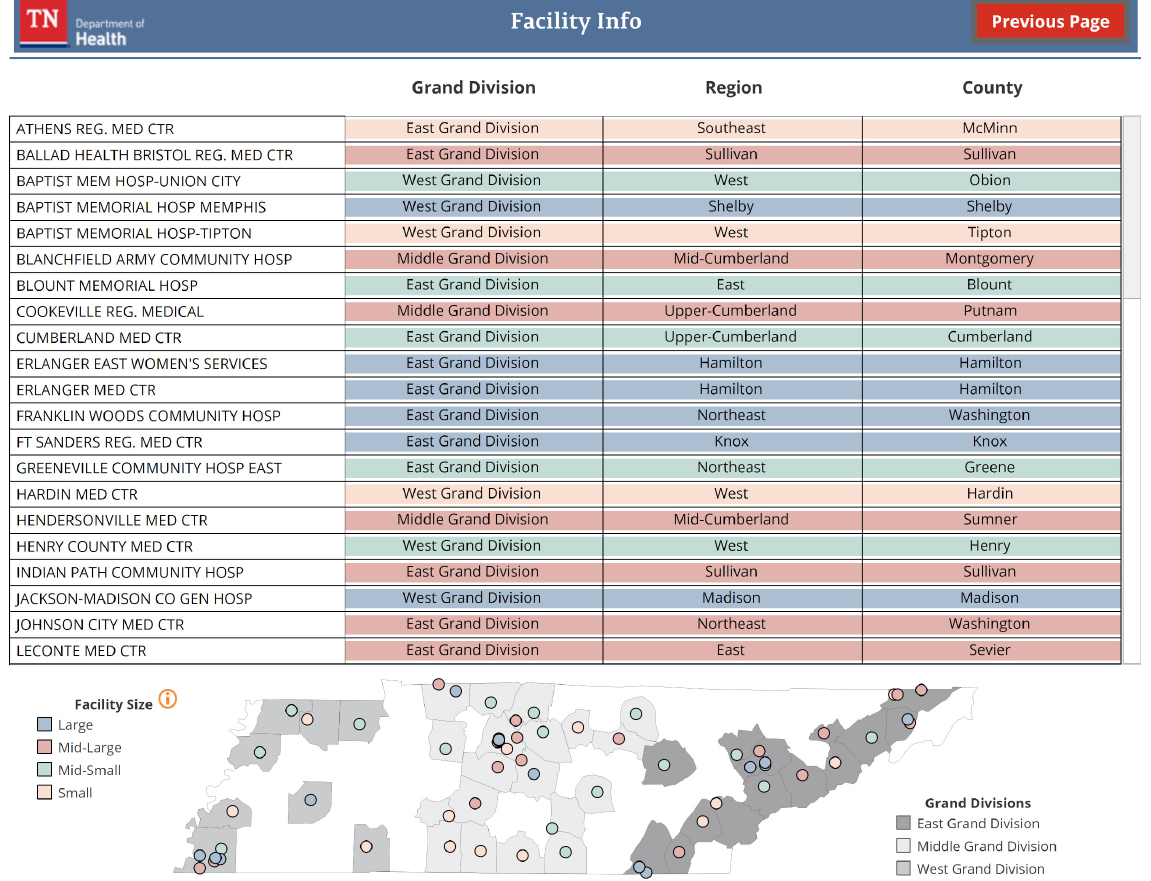
Figure 4. Information on Tennessee facilities’ county, region, and grand division location is available in a table and map. Facility size is indicated by table row and map dot color. Table 1. Dried blood spot (DBS), day of life (DOL). The eight indicators available in the dashboard are described here. Indicator-specific details are explained in the description when applicable. Each indicator’s datum is grouped based on either the facility in which an infant was born, where the infant’s DBS was collected, or where the infant’s DBS was submitted